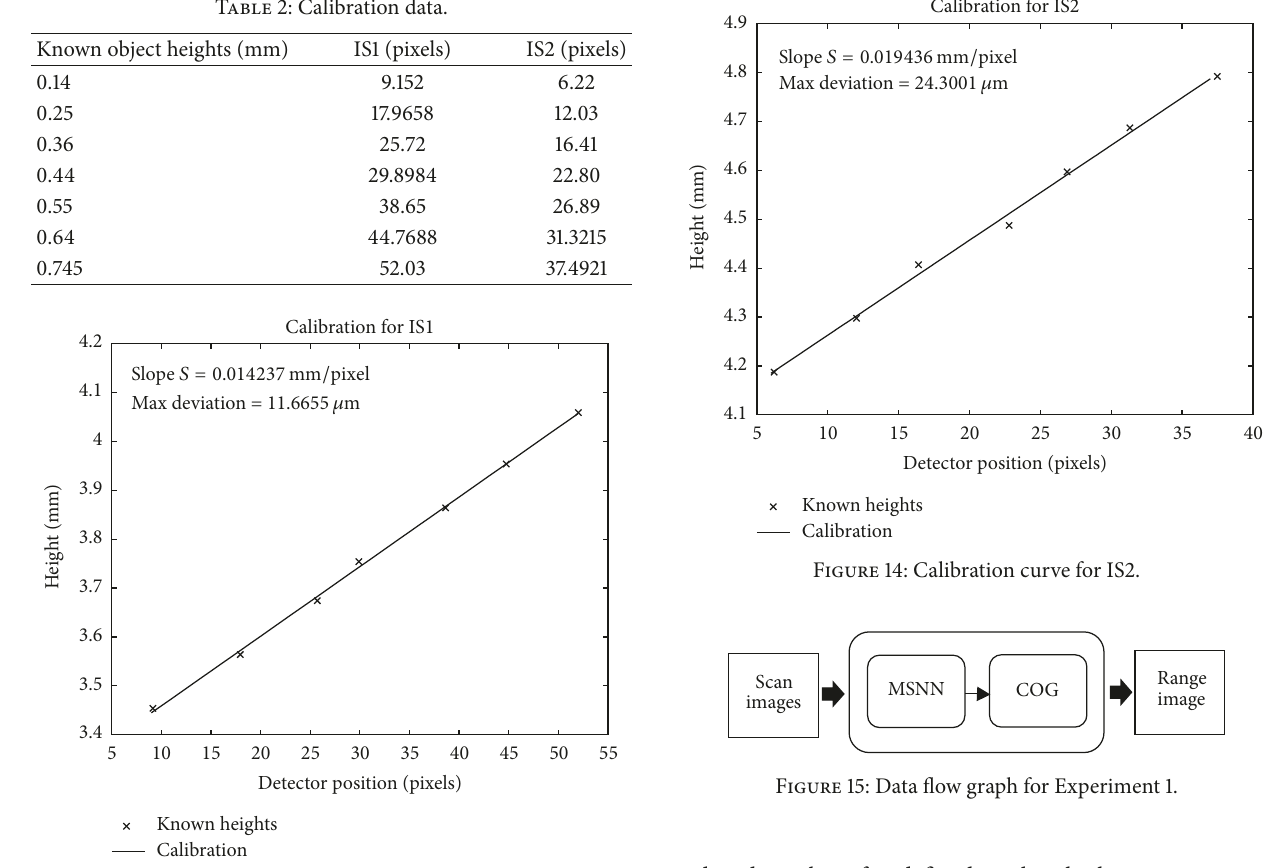
Figure 15: Data flow graph for Experiment